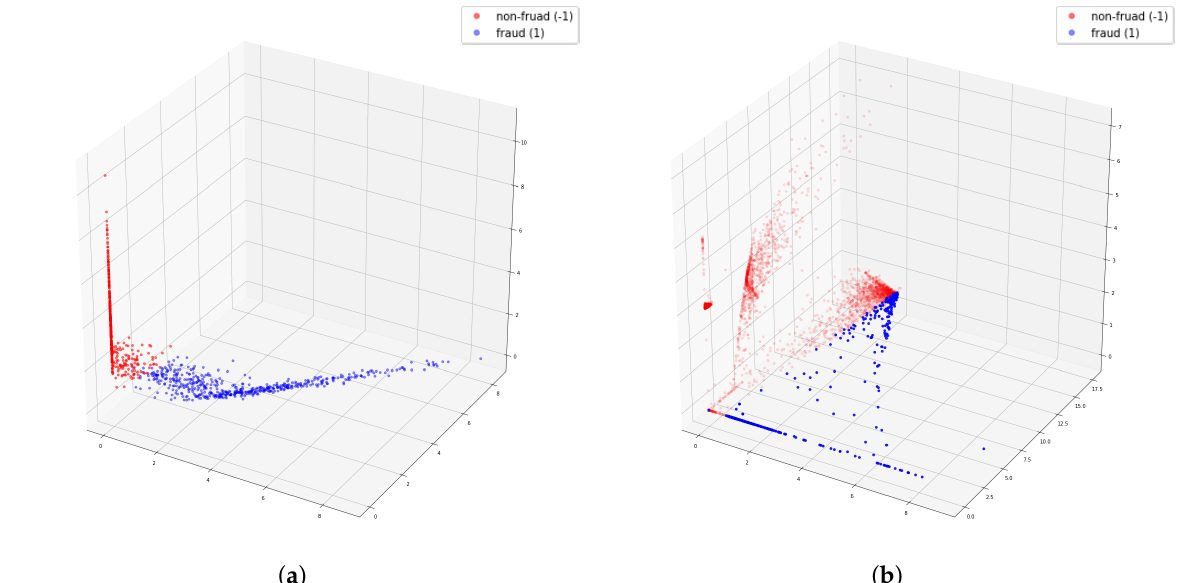
Figure 7. Latent space for the different datasets. ( a ) Synthetic dataset. ( b ) PaySim Dataset. Red samples correspond to non-fraudulent transactions. Blue samples correspond to fraudulent